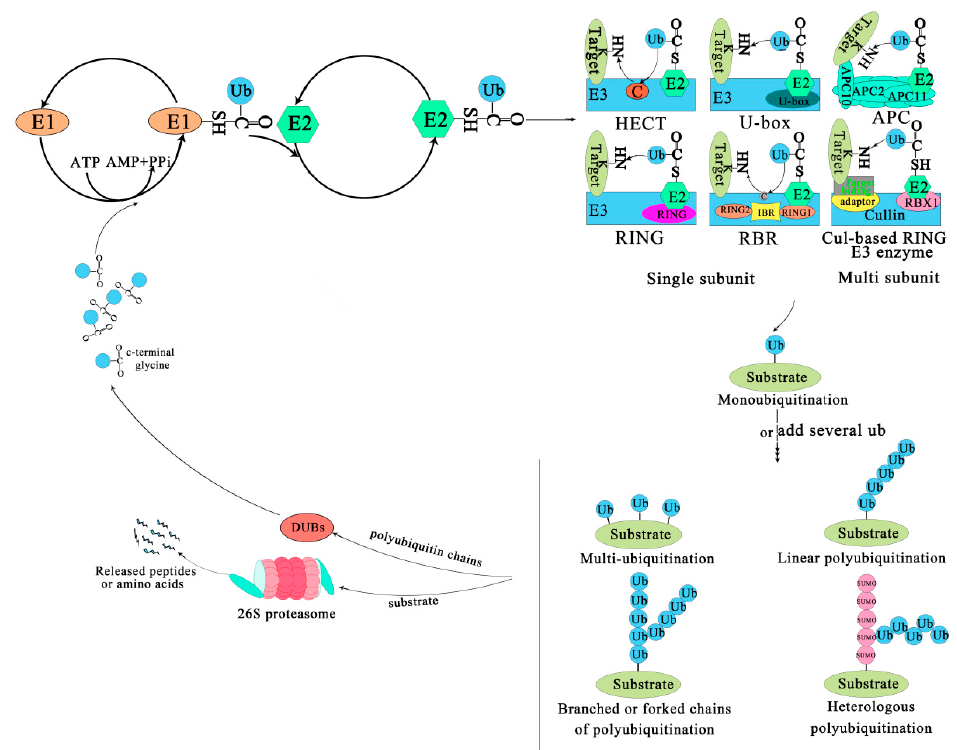
Figure 1. The ubiquitin-proteasome system. The process of ubiquitination from activation to attachment to the substrate is catalyzed by three major enzymes. The substrates labeled by ubiquitin are degraded by the 26S proteasome or play a non-degradative role in other processes. Abbreviations: APC, Anaphase-promoting complex; DUBs, Deubiquitinating enzymes; E1, Ubiquitin-activating enzyme; E2, Ubiquitin-conjugatingenzyme; E3,Ubiquitin-ligaseenzyme; Cul-based,Cullin-RINGbox1-Ligase; HECT,Homology to E6-AP C Terminus; Ub, Ubiqitin; SUMO, Small ubiquitin-related modifier; RBX1, RING-Box 1; RING, Really interesting new gene; RBR, RING1-IBR(cysteine / histidine rich